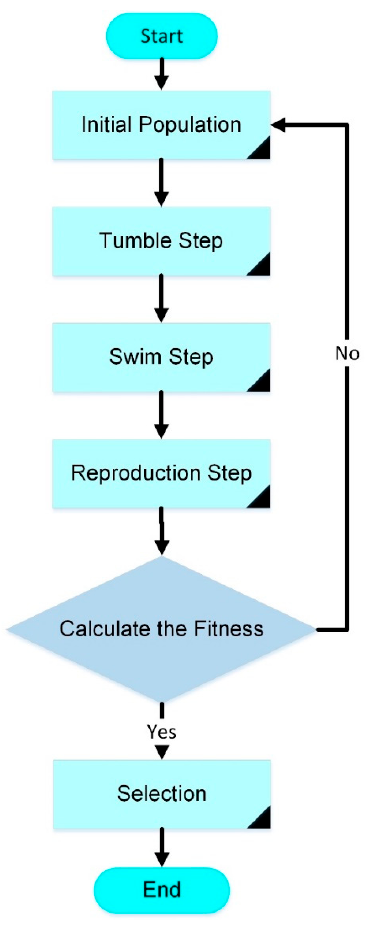
Figure 6. Flowchart of a BF algorithm.